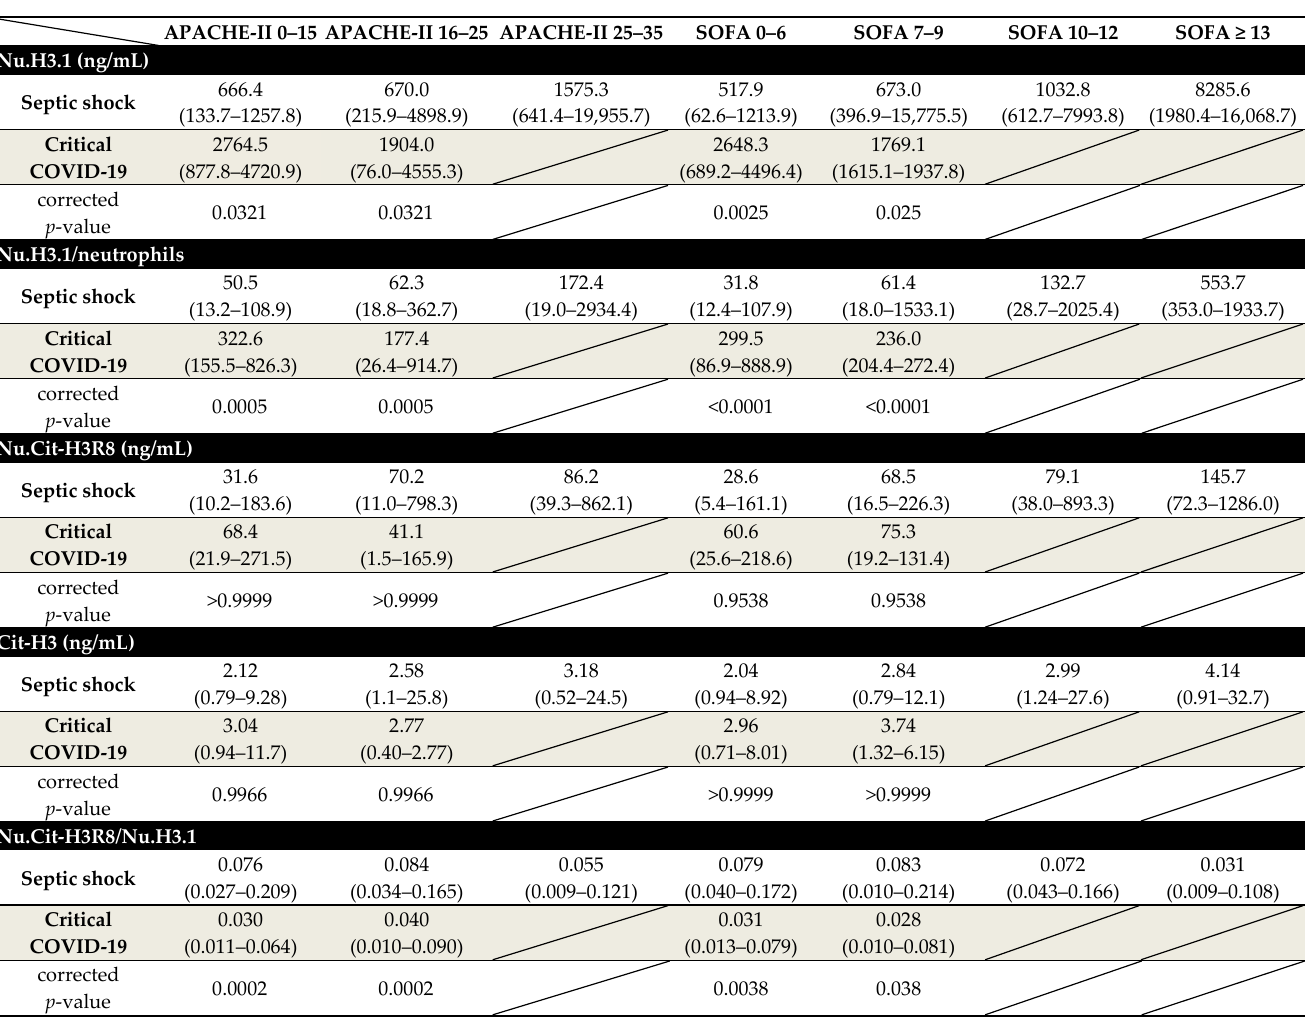
Table 2. Circulating nucleosome and histone parameters in septic shock and critical COVID-19 patients according to APACHE-II and SOFA scores. Results are reported as median with the 10th–90th percentile. Data are compared using an ordinary two-way ANOVA with p -value corrected for multiple comparisons using a Tukey’s multiple comparisons test.